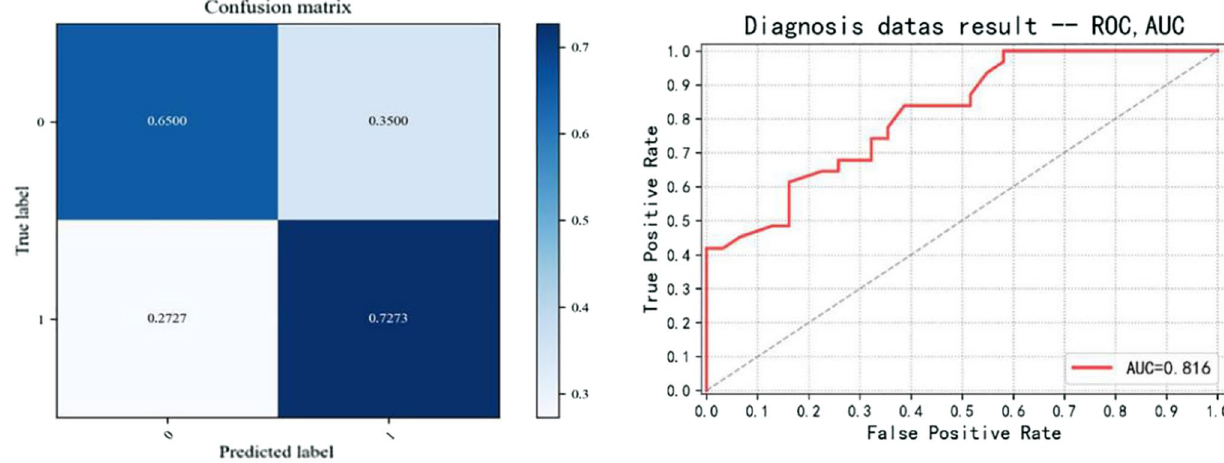
Fig. 6 Classification results visualized by the confusion matrix and relative operating characteristic